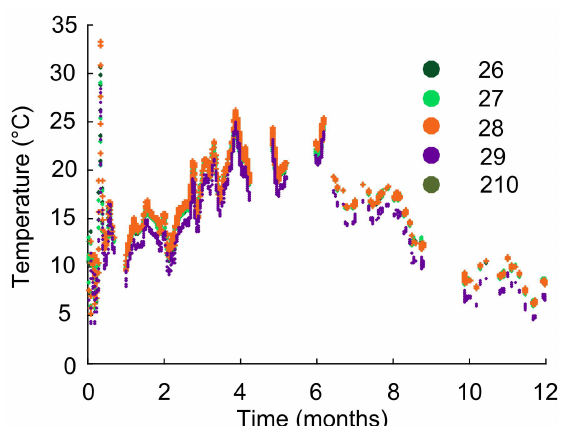
Figure 18. Measurement of the temperature using thermocouples sensors in beam 2 at the locations of the strain sensors on beam 1.